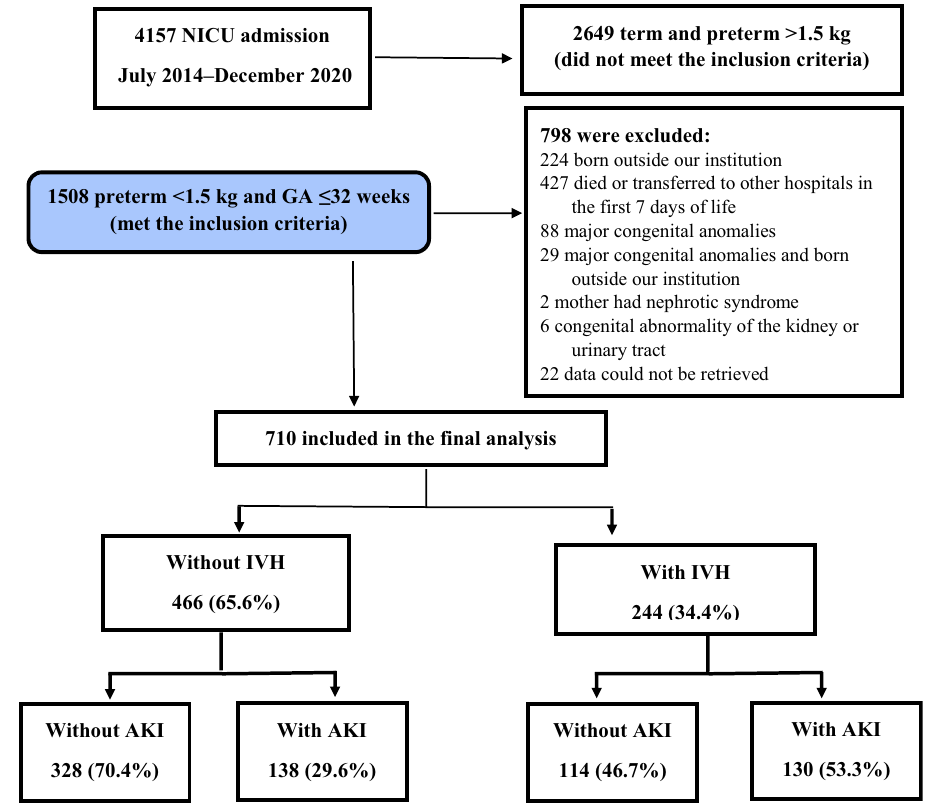
Figure 1. Flow chart of patient selection. Abbreviations: GA gestational age, NICU neonatal intensive care unit, IVH intraventricular hemorrhage, AKI acute kidney